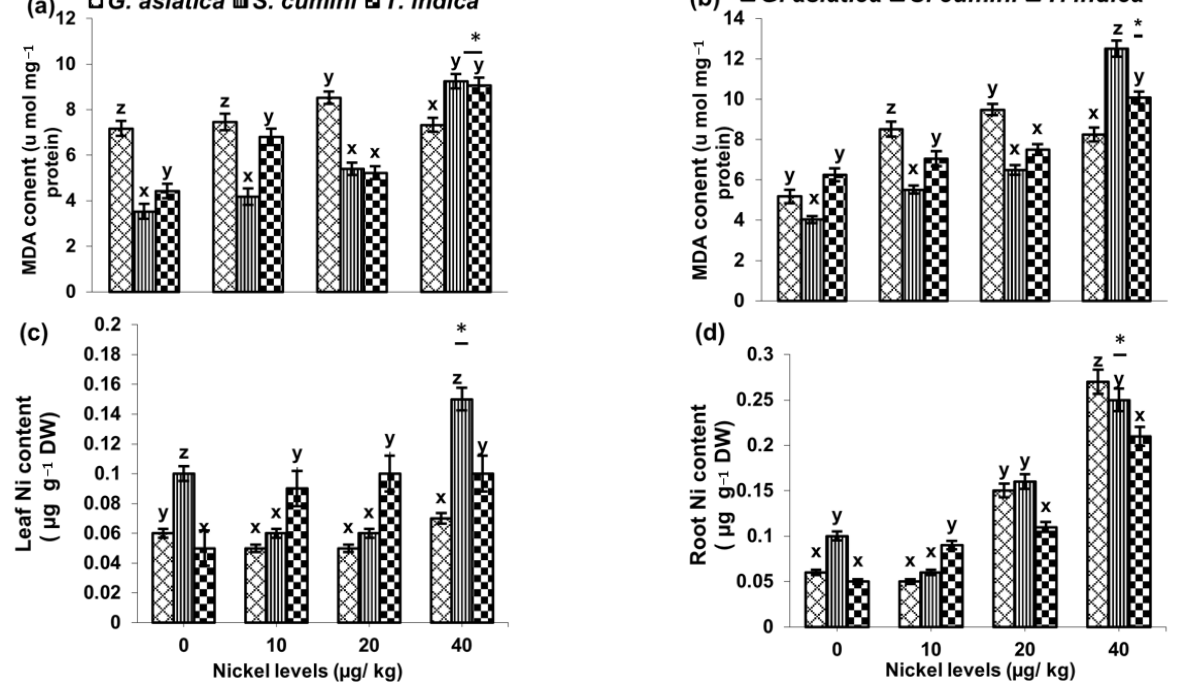
Figure 2. Malondialdehyde in leaves and roots ( a , b ) and bioaccumulations of Ni in the tissues ( c , d ) of three minor fruit species ( Grewia asiatica L., Syzgium cumini (L.) Skeels and Tamarindus indica L.) after exposure to increasing levels of Ni in the growth medium. Each mean is across three replicates with ± S.E. Different letters on each bar indicate significant difference between species (x–z), and * on each level shows a marked variability from the control, analyzed through two-factor ANOVA, with equal number of replications, followed by a post hoc multiple comparison test (DMRT).